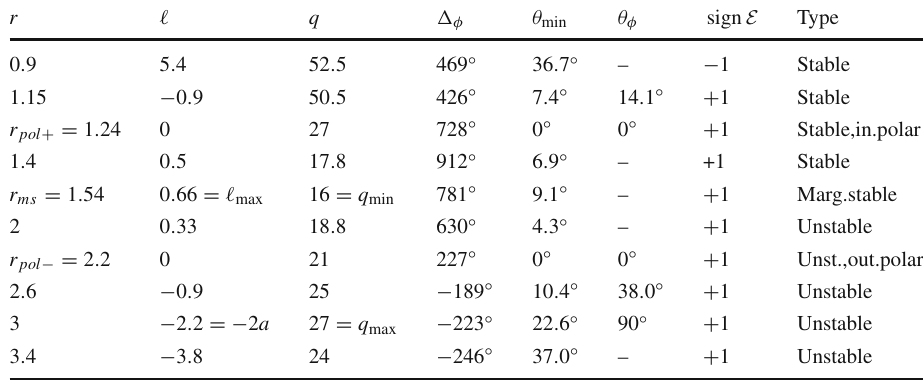
Table 3 Characteristics of the spherical photon orbits in Fig.